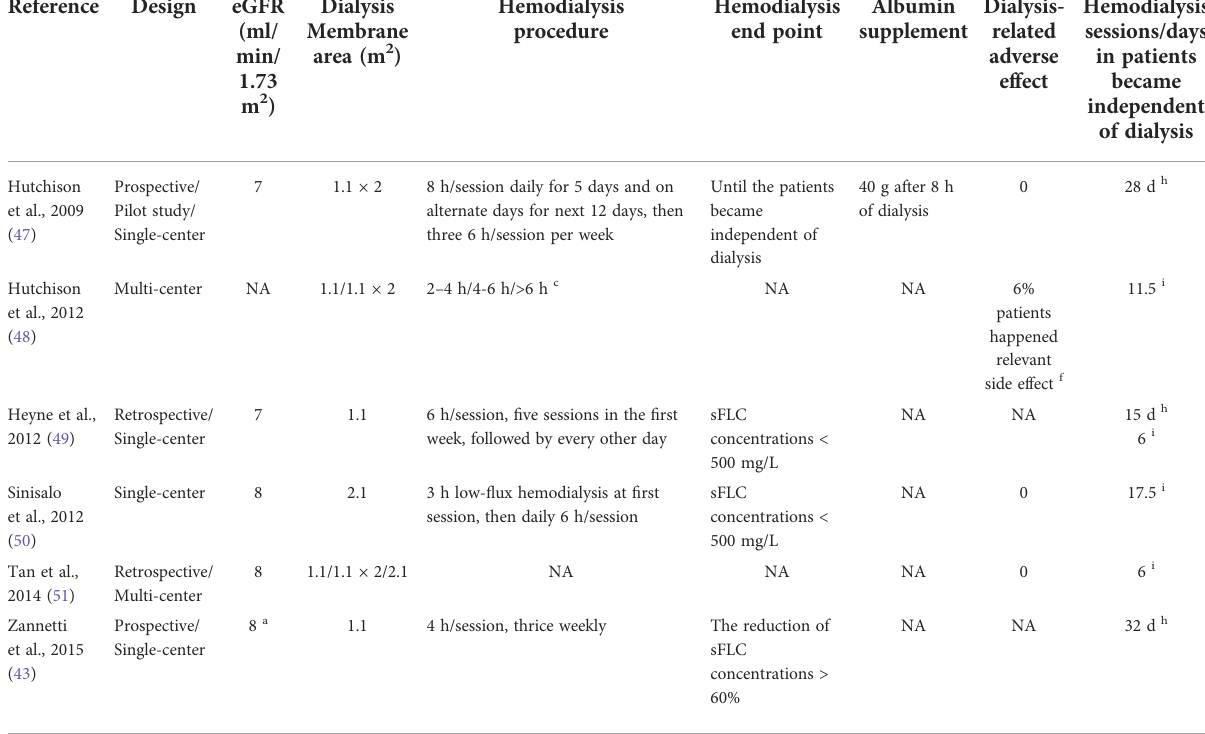
TABLE 3 The protocols of previous high-cutoff hemodialysis or high-cutoff hemodia fi ltration.